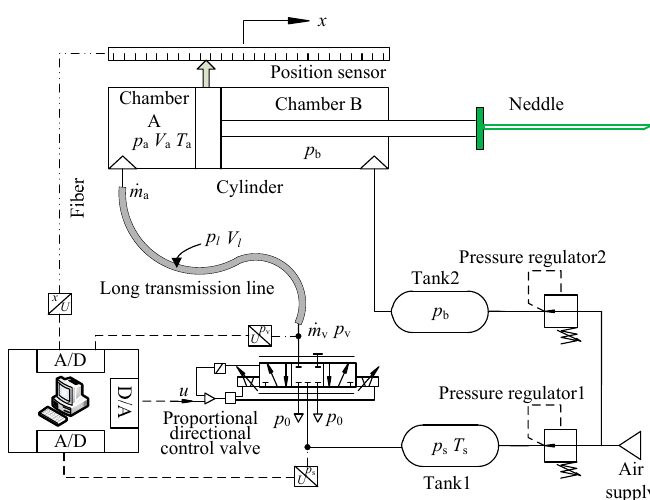
Figure 2. Schematic of the pneumatic servo system used to drive the needle insertion motion.